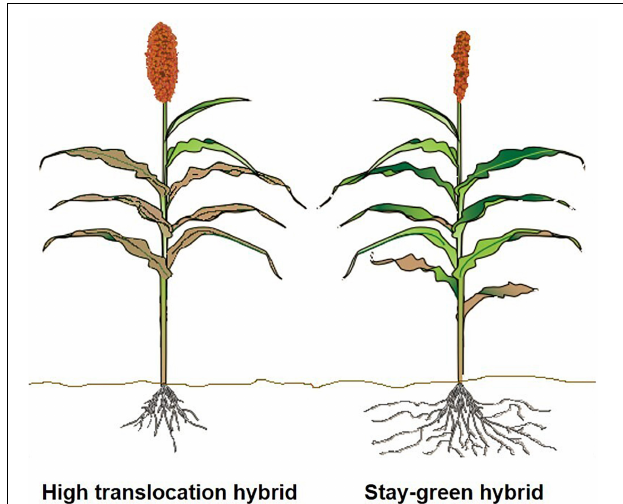
FIGURE 3 | Illustration comparing sorghum hybrids with increased terminal senescence under favorable environmental conditions with greater N translocation from leaves to increase yield and grain quality (left) versus stay-green sorghum hybrids grown under resource-poor conditions (right). Sorghum hybrids with efficient translocation of N and increased senescence under less stressful environments would potentially not require an extensive root system